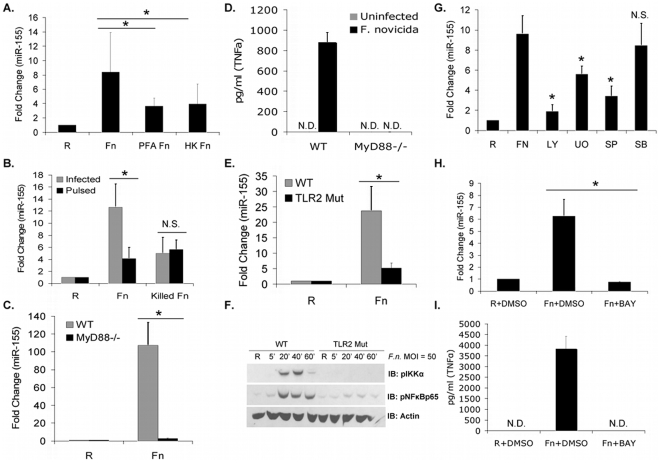
Bacterial viability contributes to miR-155 induction through the TLR pathway.(A) PBM were infected with live, heat-killed (HK), or paraformaldehyde-fixed (PFA) F.n. at an MOI of 50 for 24 hours, then miR-155 measured by qRT-PCR. (B) PBM were infected with live F.n. or heat-killed F.n. at an MOI of 50, then with or without gentamicin after 2 hours, then miR-155 was assayed by qRT-PCR. (C) Wild-type (WT) or MyD88−/− bone marrow-derived macrophages were infected with F.n. at an MOI of 50 for 24 hours, then relative miR-155 expression measured by qRT-PCR and then converted to fold change over uninfected. (D) ELISA for TNFα secretion in supernatants from the samples in Figure 3C. (E) Wild-type (WT) and TLR2 (TLR2 Mut) signaling mutant bone marrow-derived macrophages were infected with F.n. at an MOI of 50 for eight hours and miR-155 was assayed by qRT-PCR. (F) WT and TLR2 Mut macrophages were infected at an MOI of 50 of F.n. for 5, 20, 40, and 60 minutes. Cell lysates were analyzed by Western blotting for pIKKα, pNFκBp65, and Actin. (G) PBM were pretreated for 30 minutes with inhibitors of PI3K (LY), ERK (UO), JNK (SP), p38 (SB), or with DMSO vehicle control, infected with F.n. at an MOI of 50 for 6 hours, then miR-155 was assayed by qRT-PCR. (H) PBM were pretreated with the IKK inhibitor BAY7085 (BAY) or DMSO vehicle control for 90 minutes, infected with F.n. at an MOI of 50 for 6 hours, then miR-155 was assayed by qRT-PCR. (I) ELISA for TNFα in supernatants from the samples in Figure 3F. All experiments were performed in triplicate, and each experiment performed three times. Graphs represent mean and standard deviation. Data were analyzed by a paired Student t test. An asterisk (*) indicates a p-value<0.05.